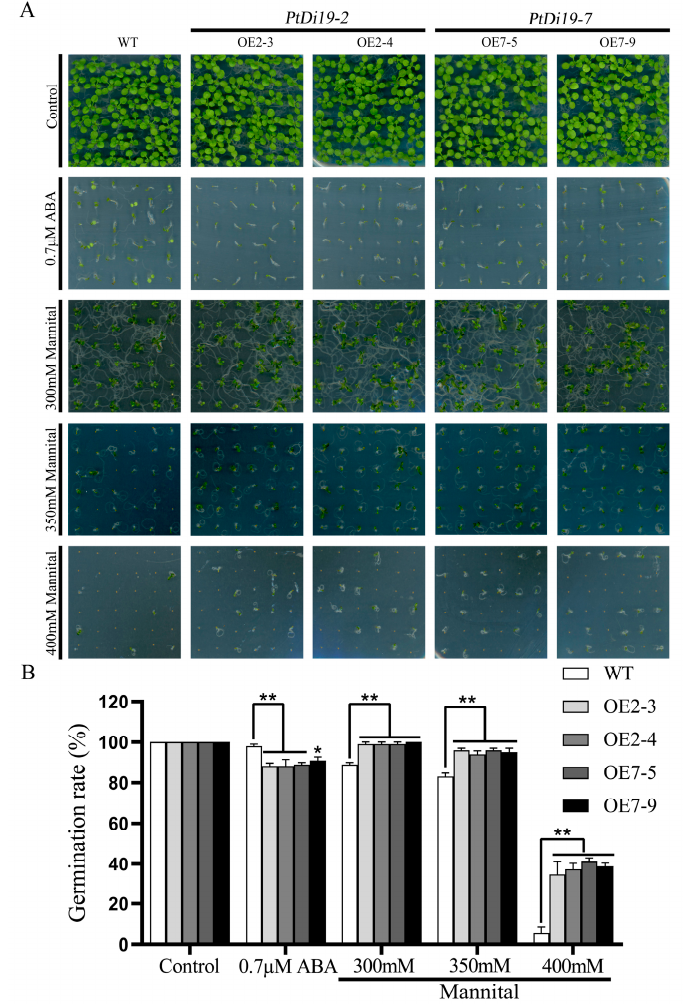
Figure 7. The overexpression Arabidopsis of PtDi19–2 and PtDi19–7 were sensitive to ABA and showed strong drought tolerance. ( A ) We spotted the seeds of WT and overexpression lines evenly on 1/2MS, 1/2MS+0.7 µ MABA, or 1/2MS+mannitol (300 mM, 350 mM, and 400 mM) to observe seed germination. ( B ) Counting of the germination rate of different lines. Asterisks indicate a significant difference compared to the corresponding controls (* p < 0.05 and ** p < 0.01). Error bars indicate SEs from three